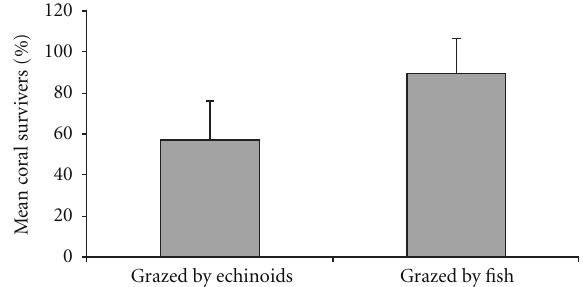
Figure 7: Surviving coral percentage of settlement plates that were grazed by echinoids ( n = 4) and settlement plates that were grazed by fish ( n =